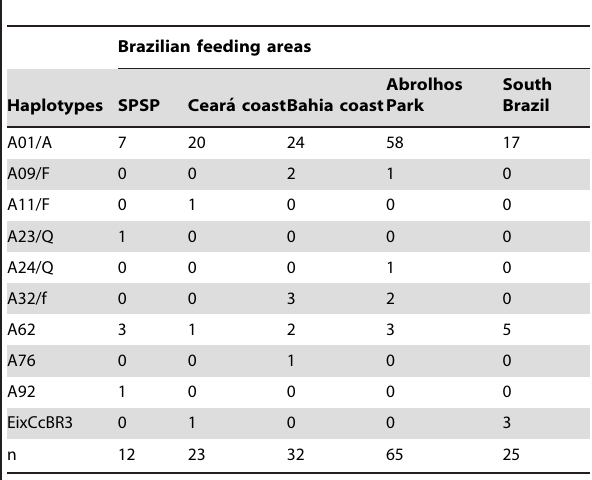
Table 1. Haplotype frequencies (740 bp) for Brazilian feeding